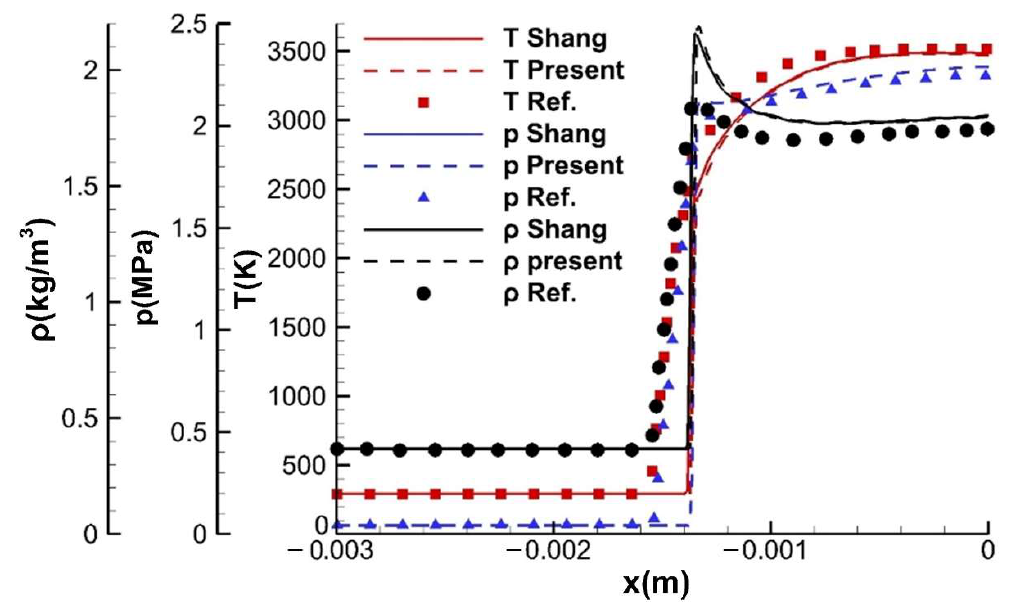
Figure 17. Pressure, temperature, and density distribution along the stagnation line of the super-detonative combustion.